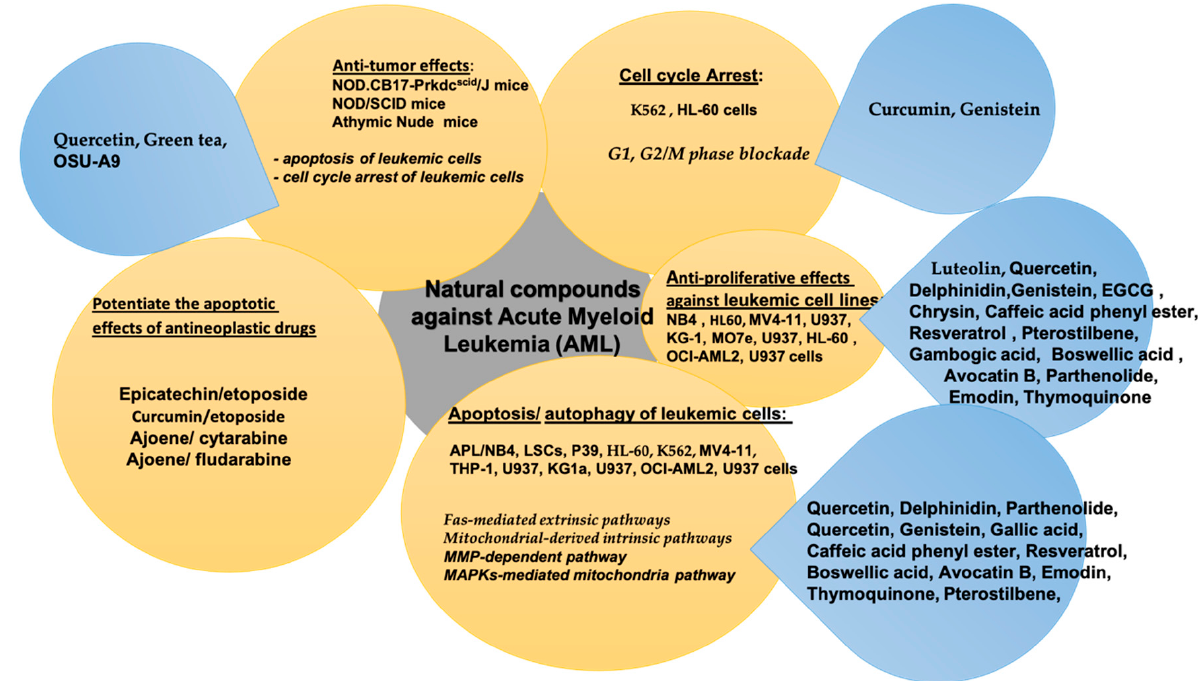
Figure 1. Natural compounds against acute myeloid leukemia (AML).